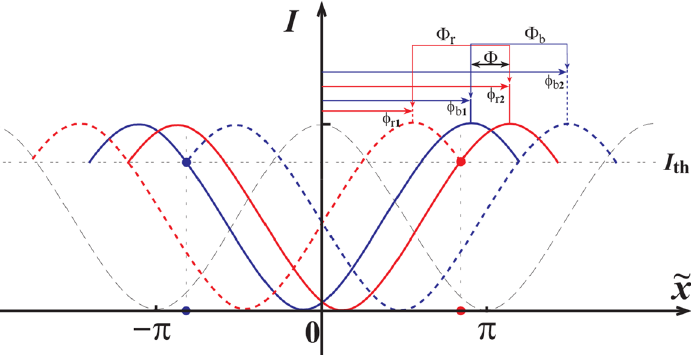
Figure 3. Interference curves for different phase differences. Black dash line is the interference curve for φ = 0 . Red dash and real lines demonstrate the range of intensity of red spot above the threshold intensity. Blue dashed and real lines demonstrate the range of intensity of blue spot above the threshold intensity.